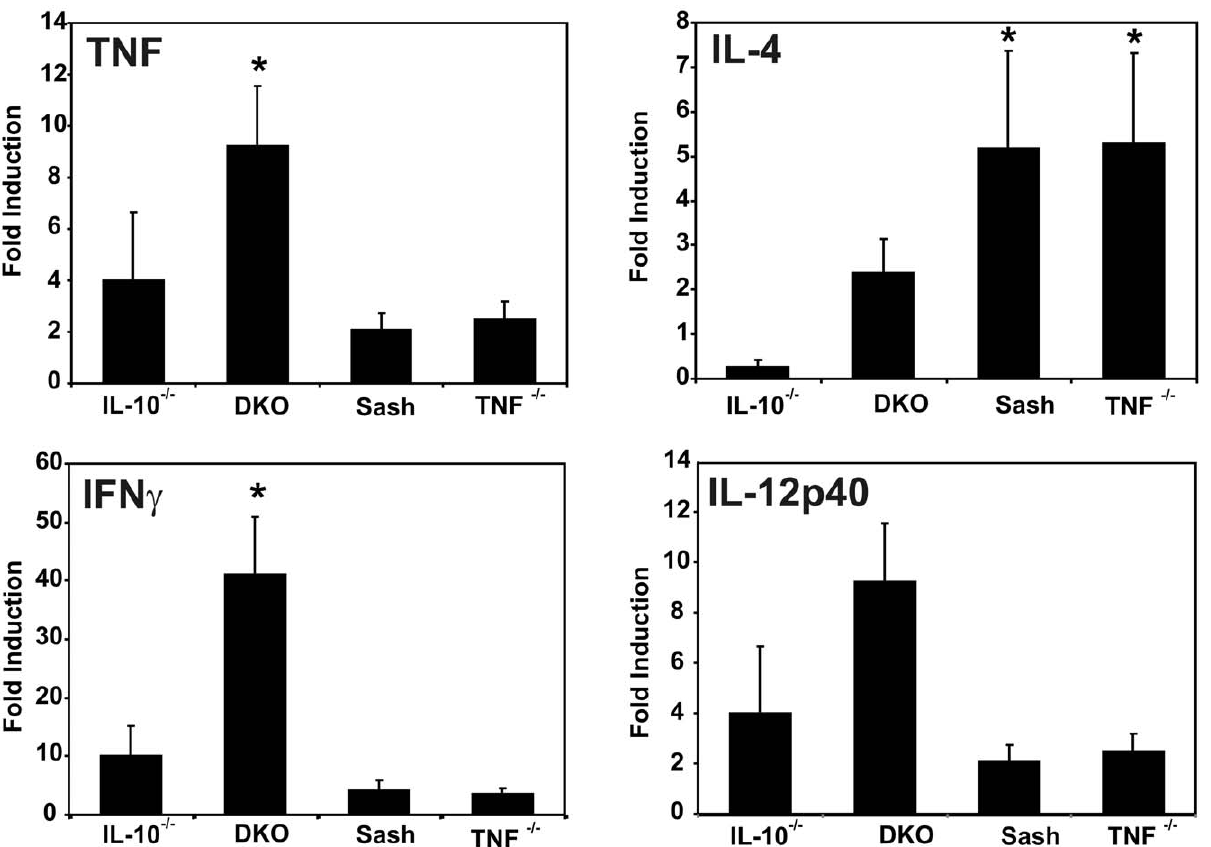
Figure 4. Mast cells modulate pro-inflammatory cytokine mRNA expression in inflamed cecal tissues. Cytokine mRNA expression in cecal tissue of mice of the indicated genotypes harvested after 5 weeks of infection with H. rodentium and H. typhlonius was measured by real-time PCR, normalized to b -actin and expressed as fold-induction relative to non-infected cecal tissue of the same genotype. Bars represent 5–6 mice per genotype. * indicates p , 0.05 compared to Il10 2 / 2 mice. Infected DKO mice have increased expression of Th1 cytokines (TNF, IFN- c ) and a trend towards increased Th2 (IL-4) and Th17-inducing cytokines (IL-12/23p40) compared with mast cell-sufficient Il10 2 / 2 mice.